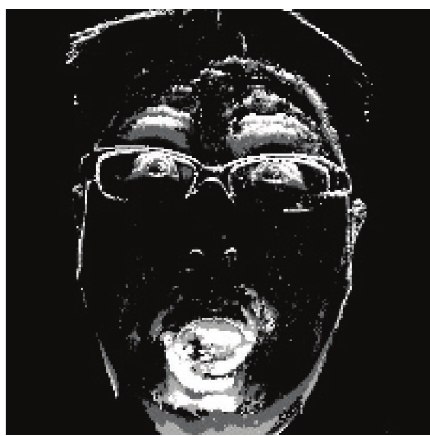
Figure 5: An MHI calculated from image